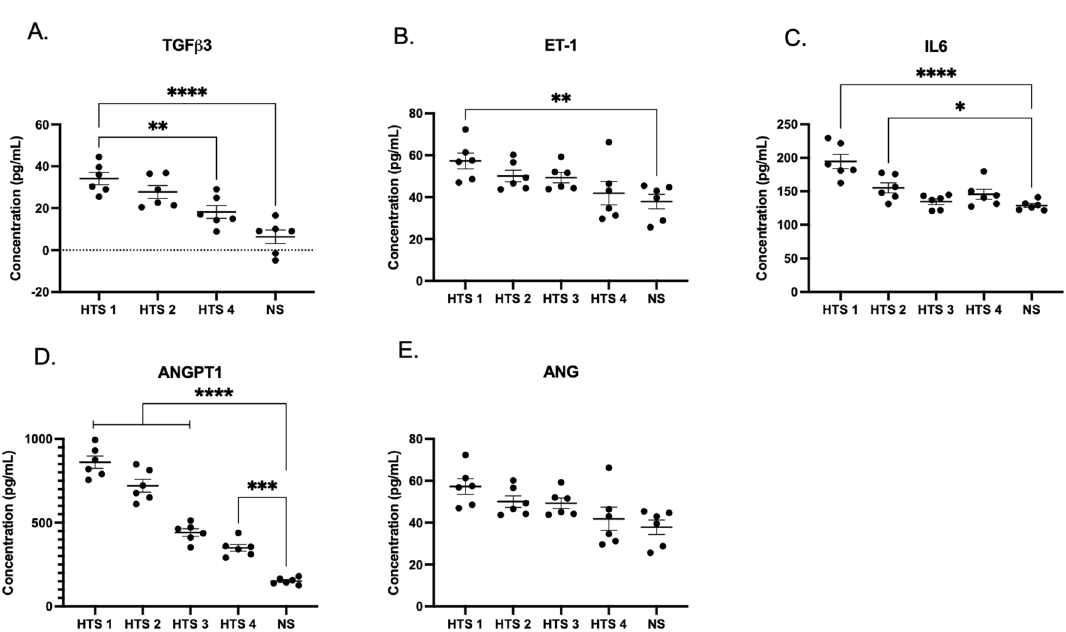
Figure 7. DMVECs from HTS differentially regulate protein expression compared to NS DMVECs in accordance with differentially regulated gene expression. ELISA measured expression of select proteins from excisional HTS DMVECs and NS DMVECs. Expression of TGFβ3 ( A ), ET-1 ( B ), IL6 ( C ), ANGPT1 ( D ), and ANG ( E ). p < 0.05*, p < 0.01**, p < 0.001***, p <